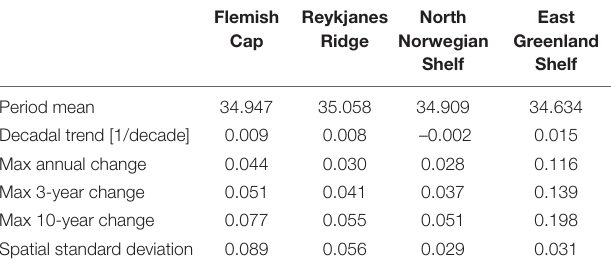
TABLE 6 | Summary of salinity properties at the four sponge habitats in areas with bottom deeper than 700 m: Period mean, decadal trend, the maximum change